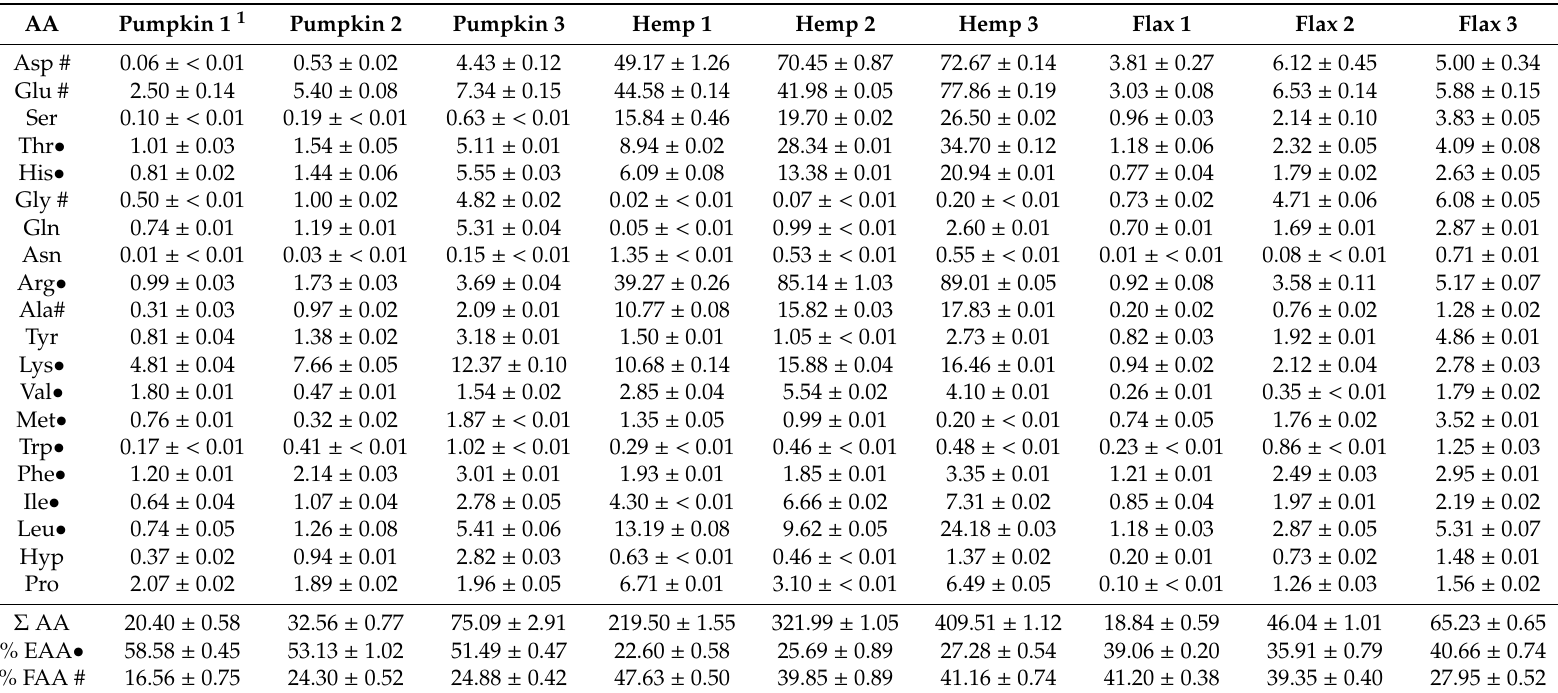
Table 3. Total amino acid composition (mg / 100 g dry extract) of oilseed cake